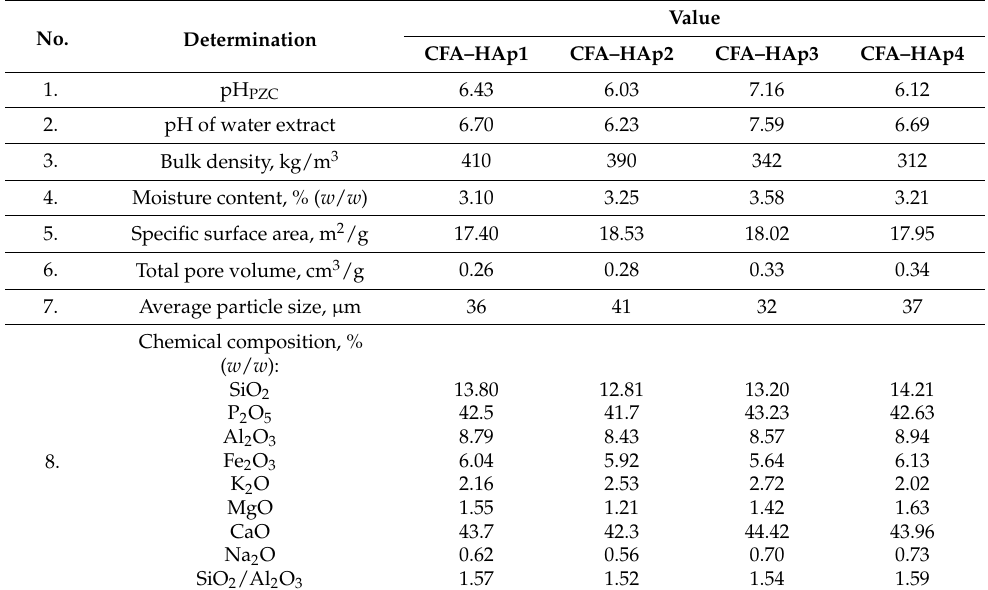
Table 2. Physical and chemical properties of the CFA–HAp composites.